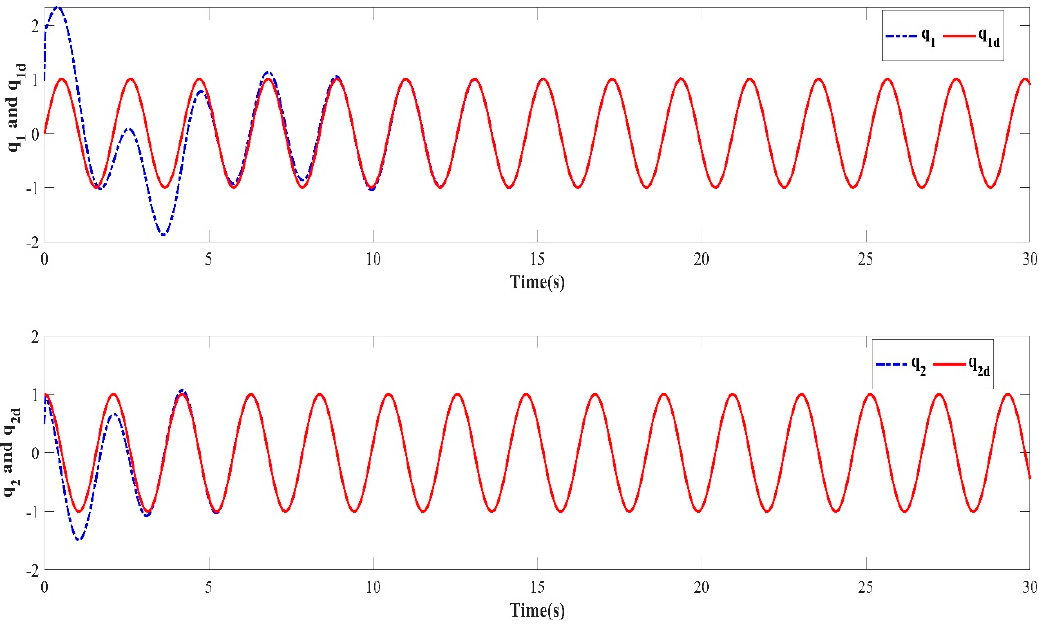
Figure 3 Learning trajectory in the first iteration.